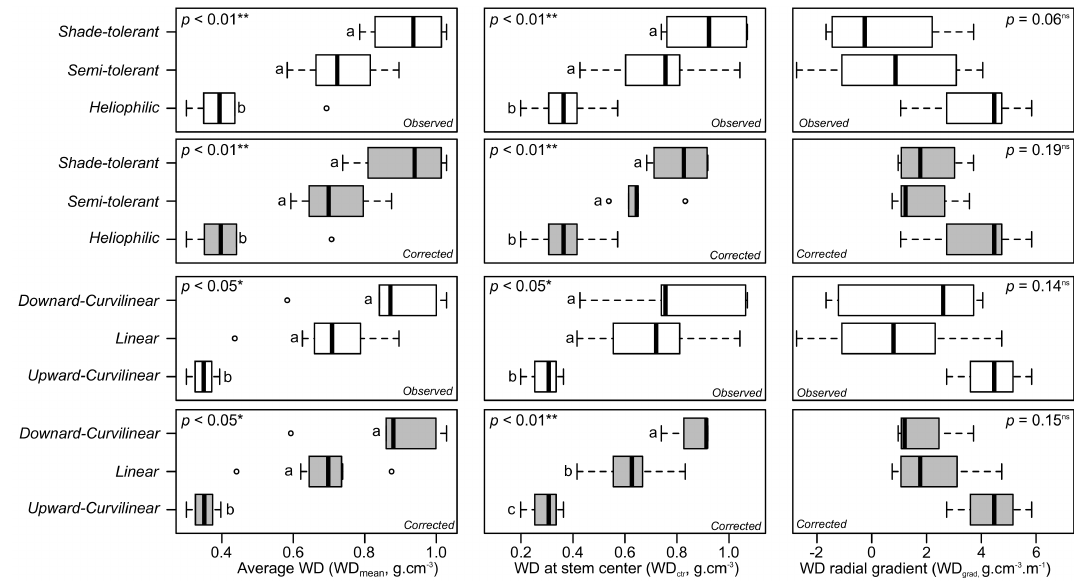
Figure 5. Relationship between WD variables, shade tolerance indexes, and WD radial patterns. White and gray boxes represent the observed and corrected values for each WD parameter. The p value ( p ) of the Kruskal-Wallis analysis of variance is indicated for each plot. Letters indicate groups after the post-hoc Tukey’s range test. Shade tolerance indexes correspond to the Favrichon classification (see material and